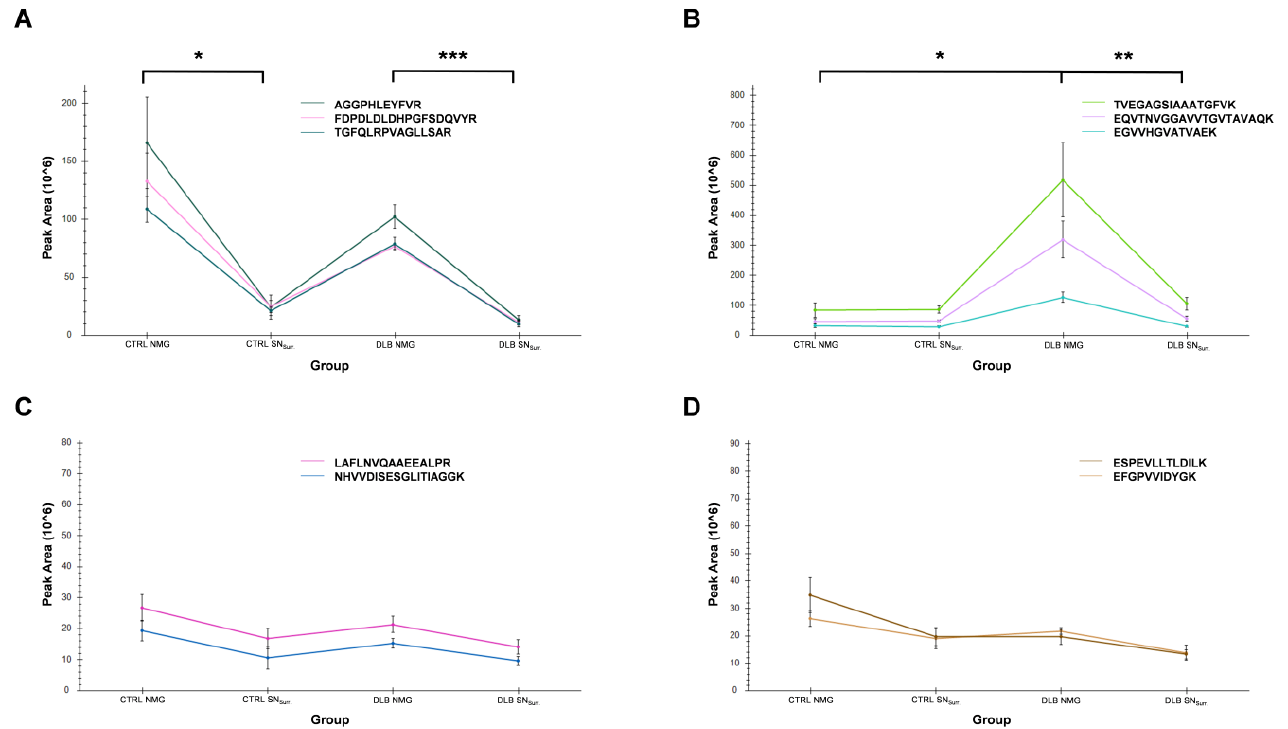
Figure 6. Parallel reaction monitoring (PRM) results for TH ( A ) and α -synuclein ( B ) as well as two reference proteins ( C , D ). Graphs show intensities of selected peptides as mean values for each sample group. TH was of significantly higher abundance in NMGs of CTRL and DLB cases, compared to SN Surr. tissue. α -synuclein was significantly enriched in DLB NMGs compared to DLB SN Surr. tissue and CTRL NMGs. As expected, glycerol-3-phosphate-dehydrogenase and cytoplasmic dynein 1 heavy chain 1 showed comparable intensities in all sample groups, providing evidence for loading of comparable sample amount. *: adjusted p -value < 0.05; **: adjusted p -value < 0.01; ***: adjusted p -value <